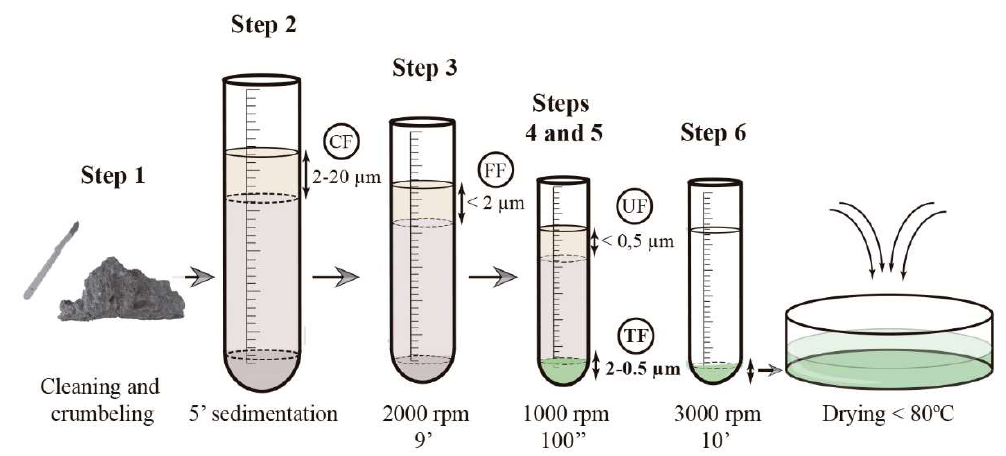
Figure 3. Extraction procedure to obtain the target fraction. Steps 2 to 5 show the mechanical separation of different particle-fractionations of the binder mortar and Step 6 shows the concentration of the extracted fraction. CF: coarse fraction, FF: fine fraction, UF: ultrafine fraction, TF: target